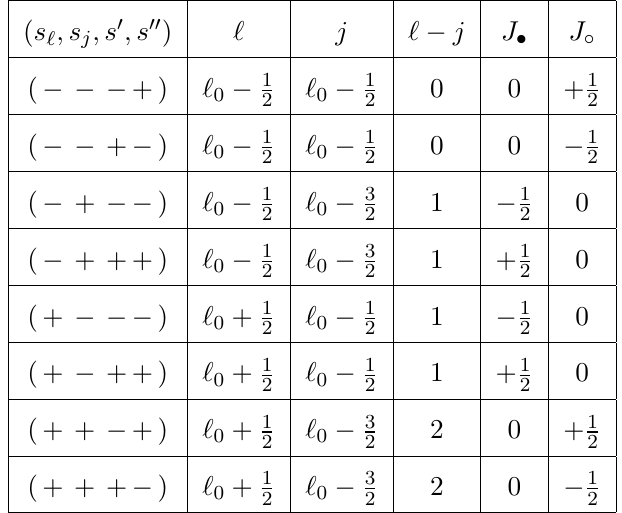
Table 9 . Level N e(cid:11) = 0 states in the R sector. In the (cid:12)rst column we adopt the shorthand notation ( (cid:6) ; (cid:6) ; (cid:6) ; (cid:6) ) for the state j ‘ 0 ; ‘ 0 (cid:0) 1 i NS